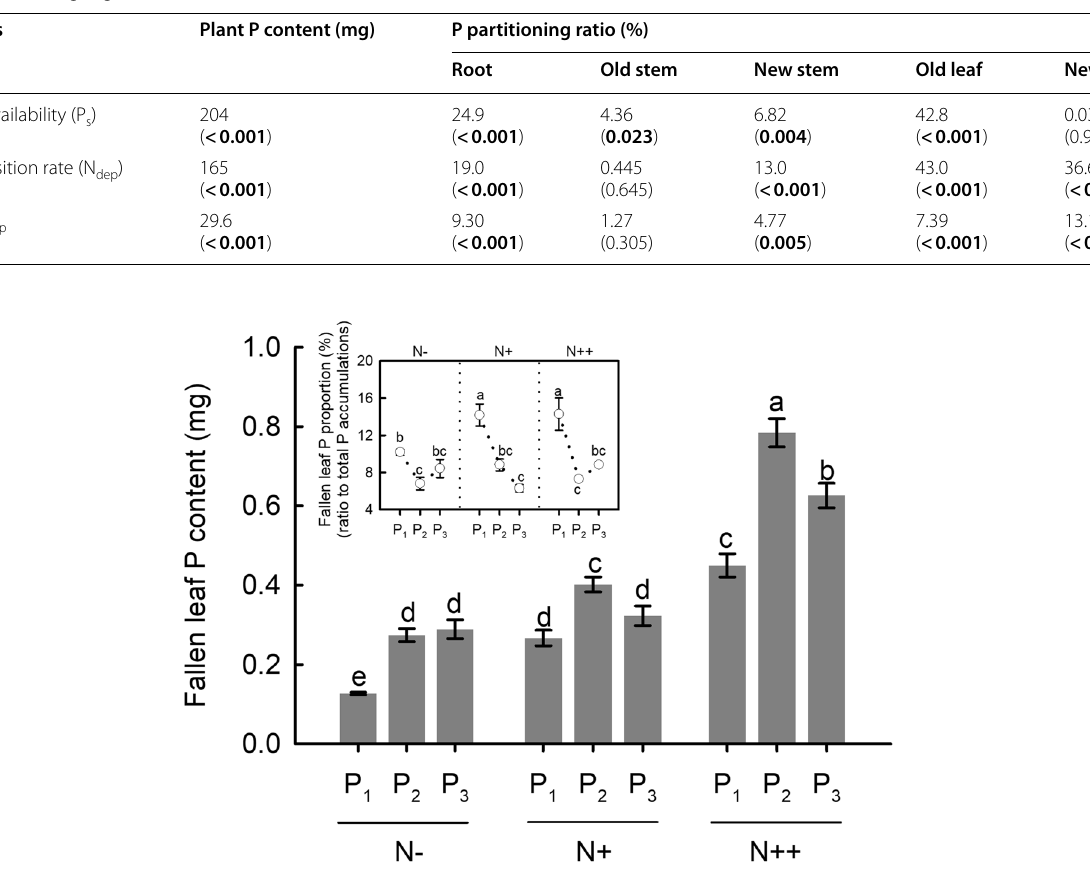
N ) on plant P content of P. edulis s × dep